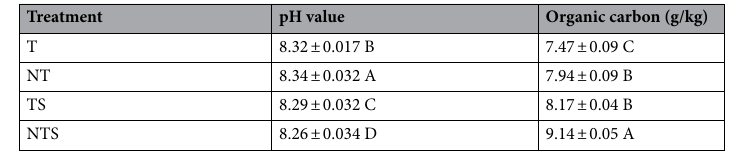
Table 5. Changes of soil chemical properties of 0–10 cm spring wheat under different treatments. Different capital letters indicate significant differences among different treatments ( P < 0.05).